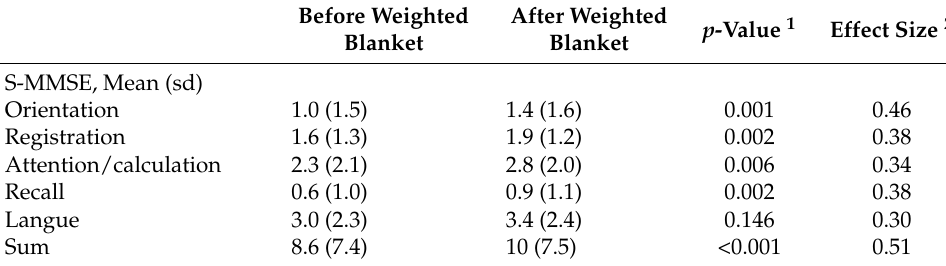
Table 3. S-MMSE before and after utilisation of weighted blanket for 28 days, n = 68.